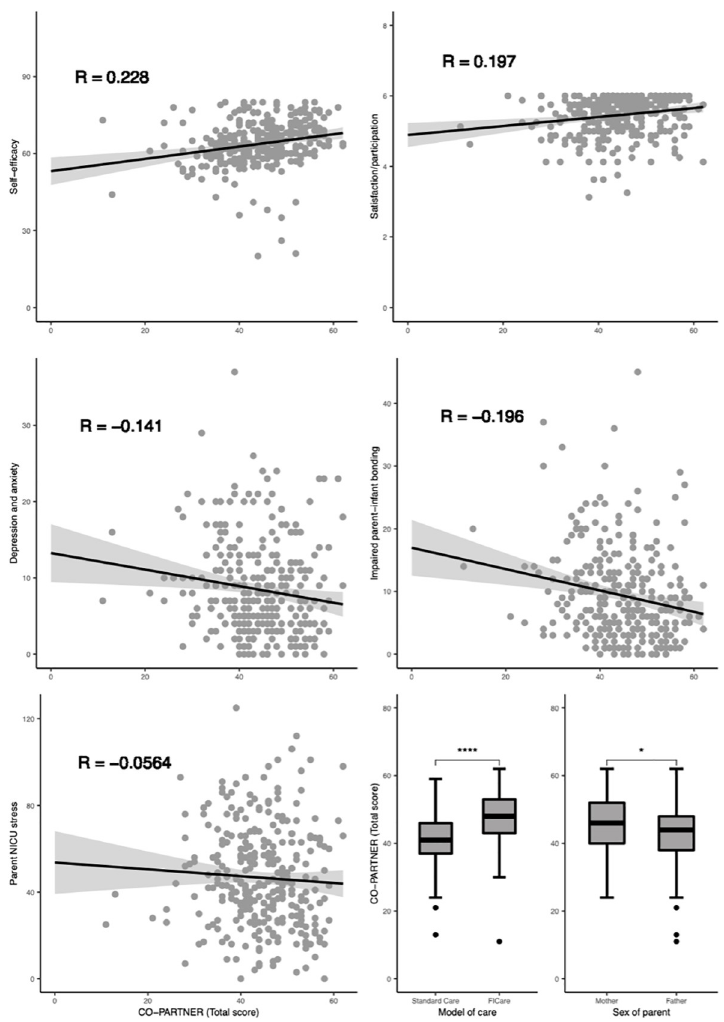
Fig 2. Results of hypothesis testing. Scatterplot and boxplot values are shown from the first imputed dataset. Correlation coefficients and significance are pooled outcomes from all imputed datasets. r: correlation coefficient (Pearson’s